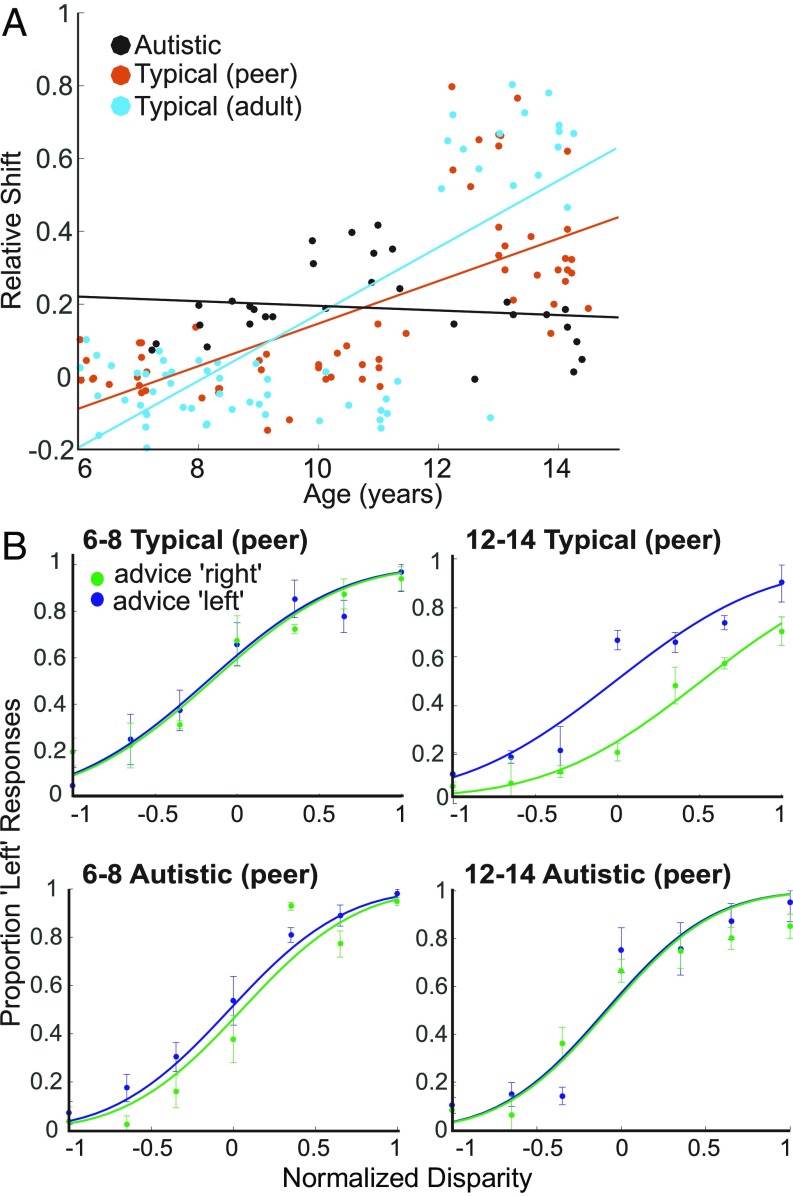
Individual participants’ psychometric functions under leftward and rightward social influence. (A) Each data point plots the relative shift (bias) between the two fitted Gaussian functions for one participant under the two different directions of social influence against the participants age at the time of testing. The shift was measured after normalizing each participant’s tested disparity range to ±1. Most neurotypical children below the age of 11 y showed no or only a small bias in their response function in the direction of social influence, in contrast to neurotypical children aged 12 to 14 y. For both neurotypical experimental groups, there was a moderate positive linear relationship between age and shift size (peer correlation coefficient r = 0.69; adult r = 0.76). In autistic children, an earlier, weak bias to social influence appeared reduced in the older children, which was reflected in the weakly negative linear relationship between age and shift size (r = −0.14). (B) Representative individual psychometric functions from the youngest and oldest age groups for matched neurotypical and autistic participants. Error bars show 95% confidence intervals. All individual functions are shown in SI Appendix, Fig. S1.